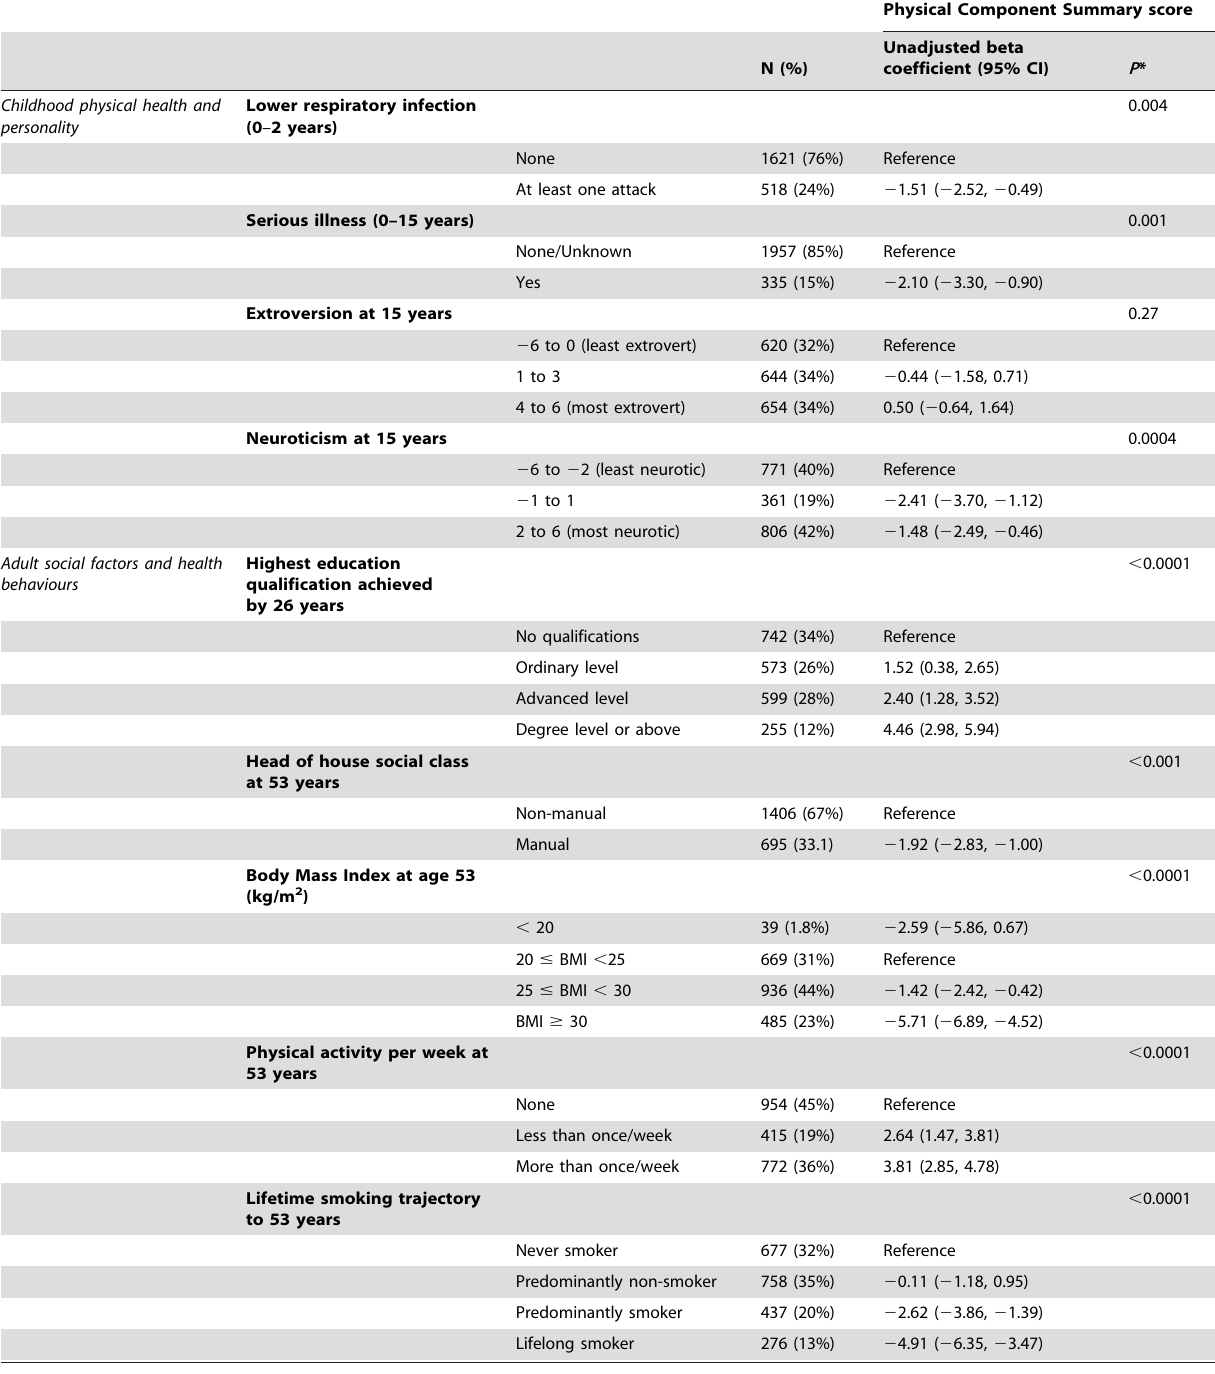
Physical Component Summary